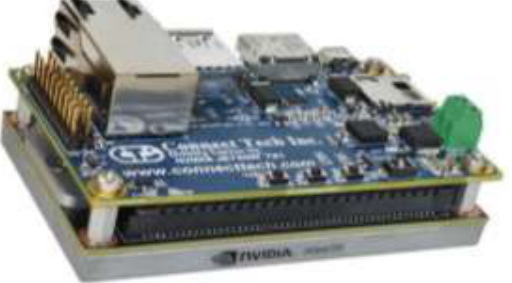
Fig. 10. Orbitty Carrier for NVIDIA® Jetson™ TX2